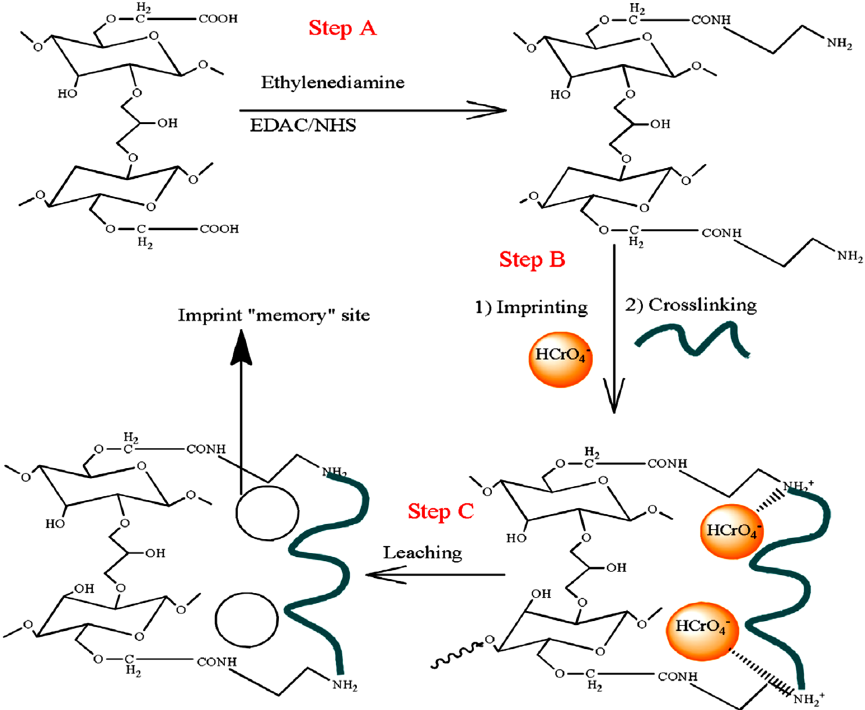
Figure 15. Preparation scheme of CMC/EDA imprinted polymer (reproduced with permission from Ref. [154]. Copyright 2017 Elsevier).